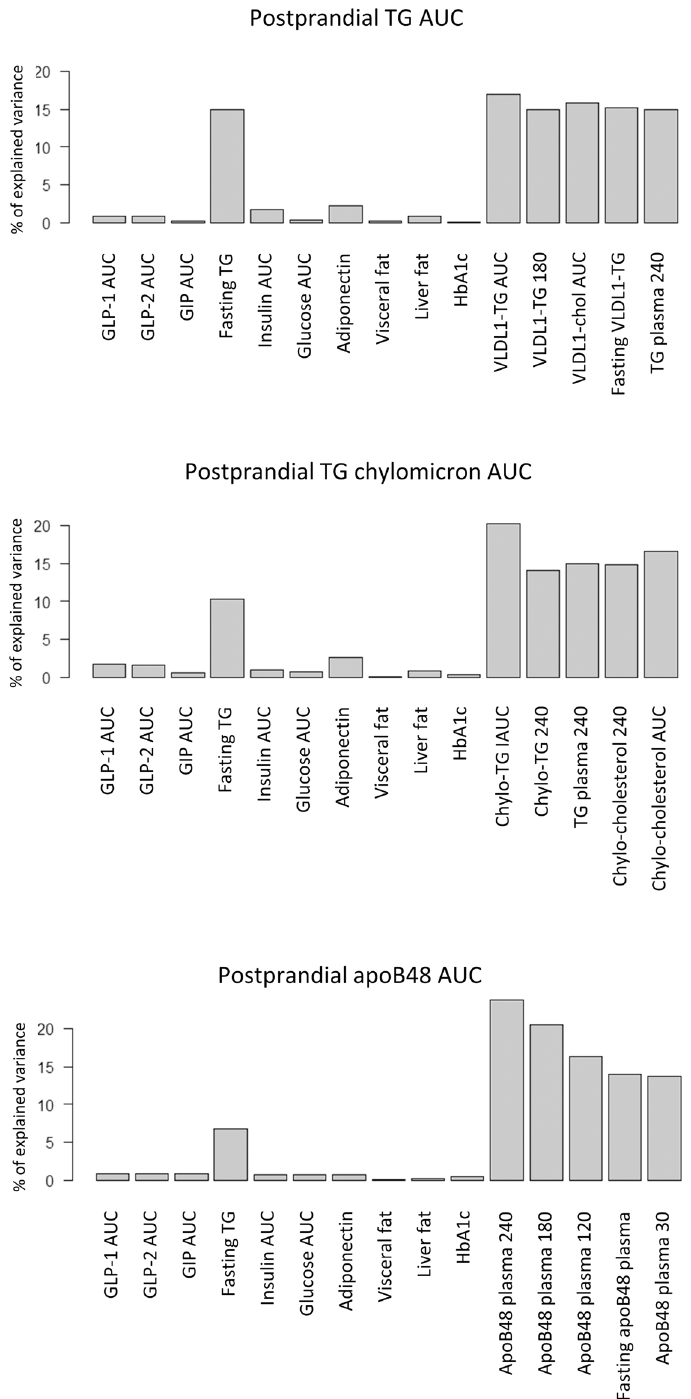
Fig 3. Relative importance analysis. Contribution of each variable for explaining (A) the plasma TG AUC (B) the TG-chylomicron AUC and (C) the apoB48 AUC after the fat-rich meal. For every plot 15 variables are shown. Ten variables including GLP-1, GLP-2 and GIP (to the left in each plot) are shared between (A), (B) and (C). Five variables to the right hand side in the graphs vary between (A), (B) and (C). These five were chosen as they correlate most strongly with the response variable in question and thus provide a relative importance reference to the other ten variables.